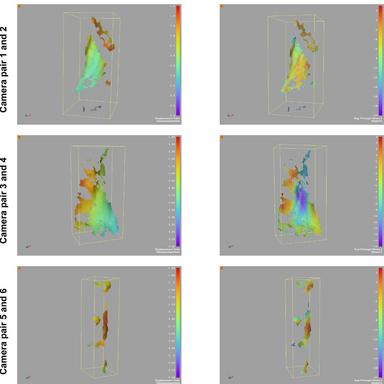
Total displacement and true strain across the surface of an ACL at maximum load from all three camera pairs. Additional images showing load-displacement distribution can be found in Supplementary Material (Supplementary Materials Fig. S4). (For interpretation of the references to color in this figure legend, the reader is referred to the web version of this article.)